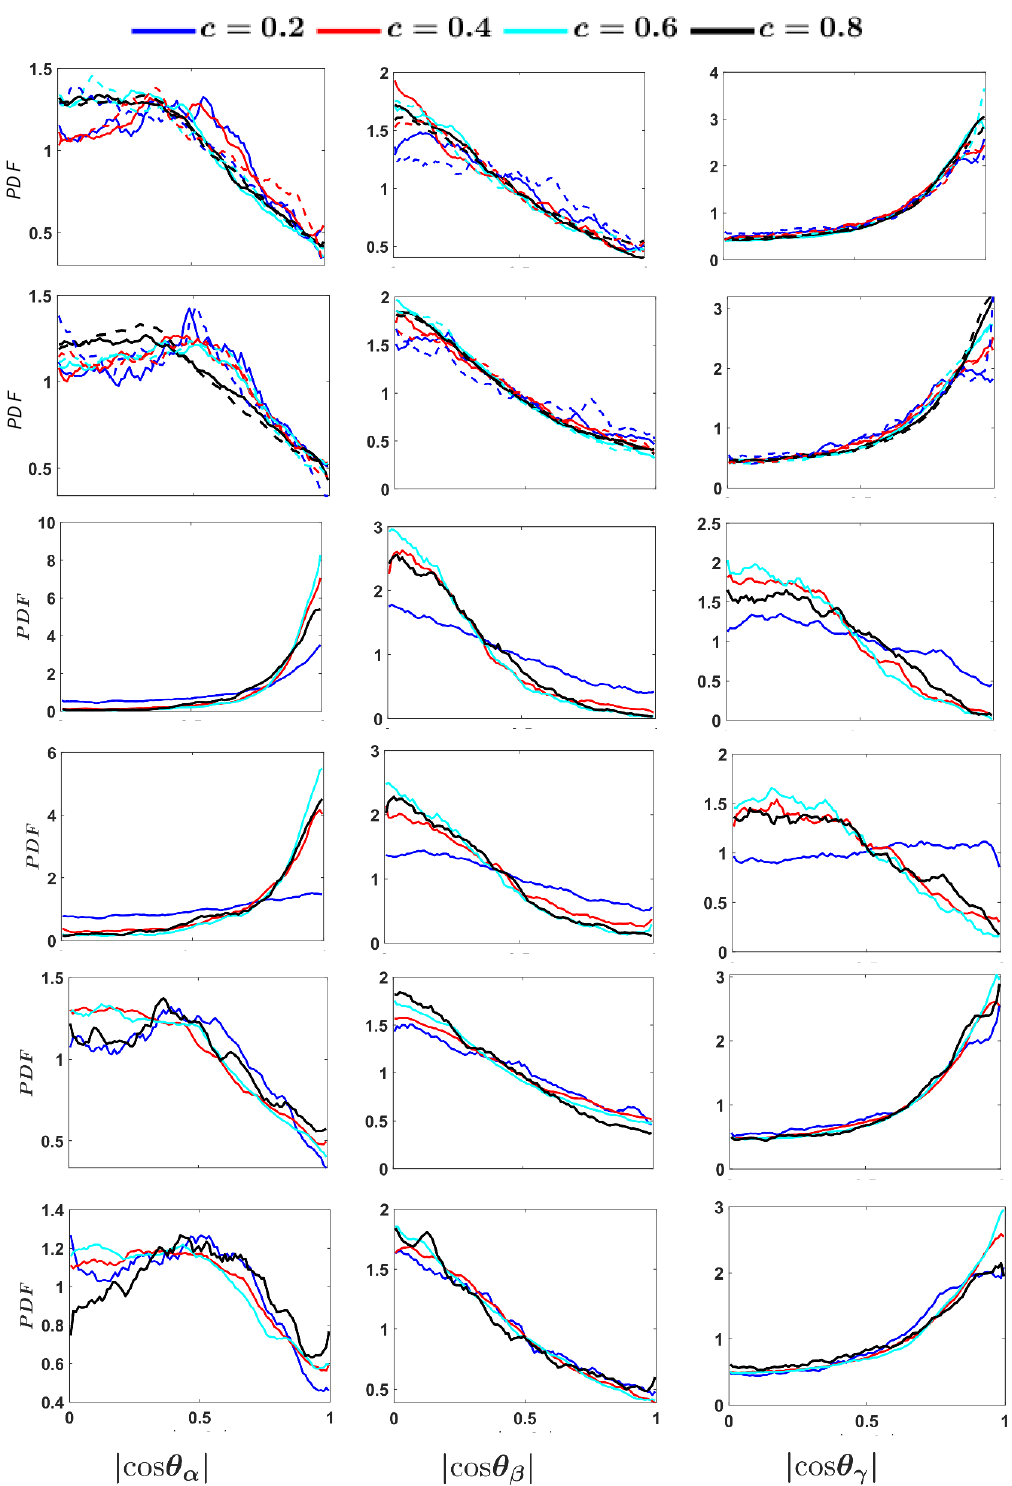
Figure 10. PDFs of |𝑐𝑜𝑠𝜃 𝛼 |,|𝑐𝑜𝑠𝜃 𝛽 | and |𝑐𝑜𝑠𝜃 𝛾 | (1 st to 3 rd column) for (1 st and 2 nd rows) MILD combustion (4.8% solid line 3.5% dashed line), (3 rd and 4 th rows) premixed combustion and (5 th and 6 th rows) passive scalar mixing cases with initial u (cid:48) / S L = 4.0 (1 st , 3 rd , 5 th row) and 8.0 (2 nd , 4 th and 6 th